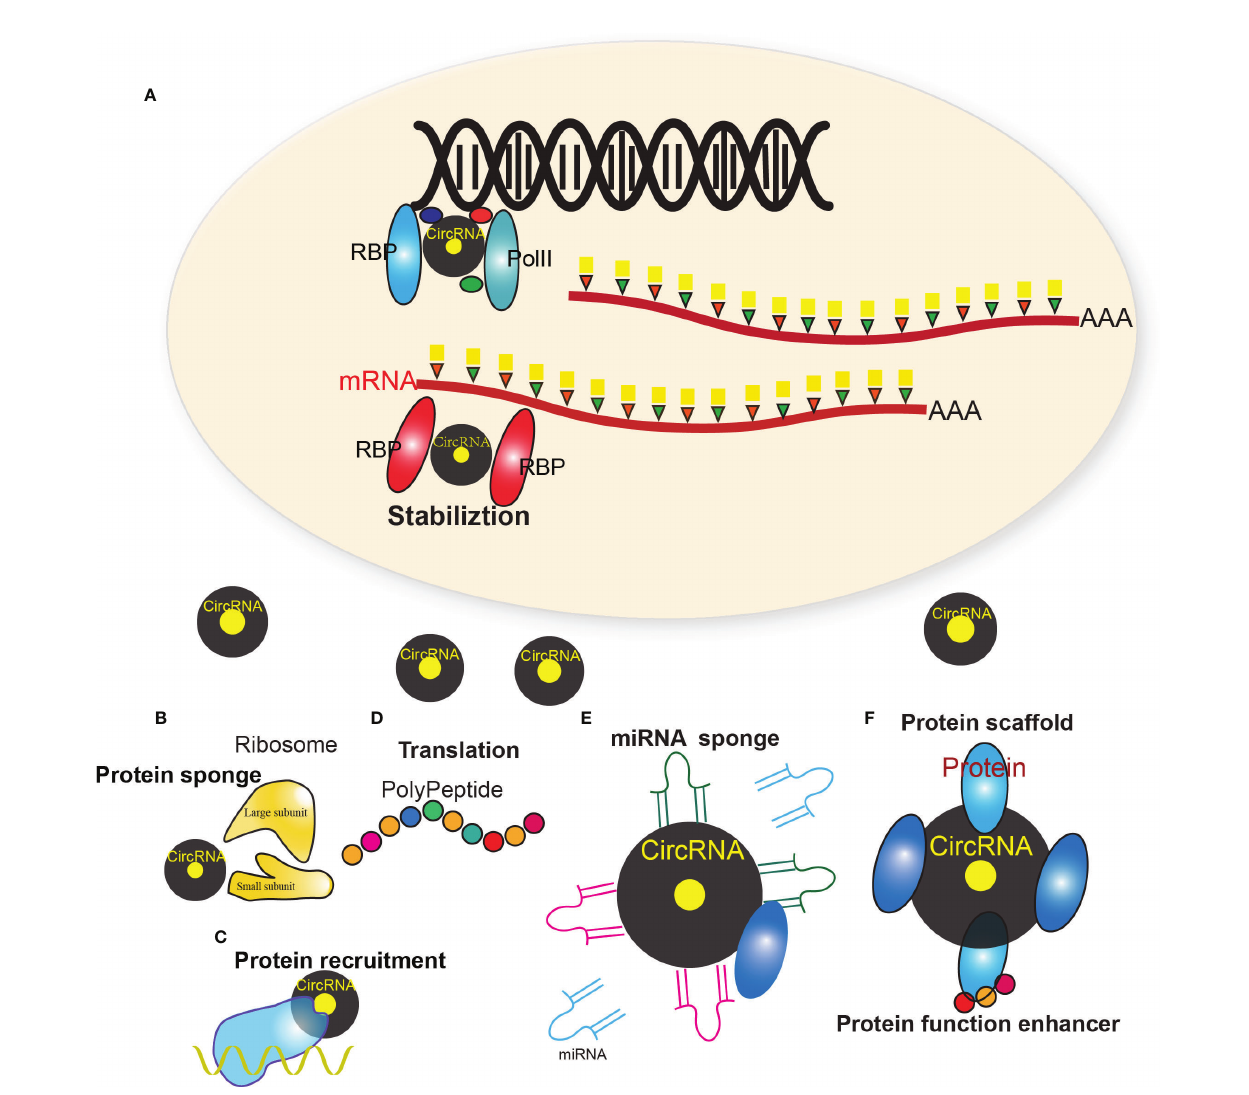
FIGURE 1 | Multiple regulatory mechanism of circRNAs. (A) The biogenesis of circRNAs mainly involves the complex of PolII, RBPs and other factors. (B) CircRNAs that harbor RNA binding protein (RBP) binding motifs may serve as sponges/decoys of the corresponding proteins and regulate their functions. (C) CircRNAs may also recruit speci fi c proteins to certain loci or subcellular compartments. (D) Some circRNAs harbor internal ribosome entry site elements and AUG sites, which enables circRNAs to be translated to unique peptides under certain circumstances. (E) Many circRNAs were found to act as miRNAs sponges, which sequester miRNAs via complementary RNA base-pairing and thus prevent miRNAs from binding their target. (F) Some circRNAs have been shown to facilitate the colocalization of enzymes and their substrates through acting as protein scaffolds. CircRNAs may also enhance the function of particular proteins through circRNA- protein